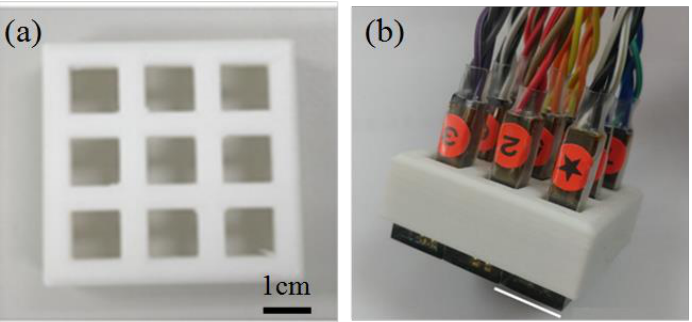
Figure 11. Photographs of: ( a ) 3D-printed Hall sensor frame, and ( b ) 3 × 3 Hall sensor array consisting of 9 sensing modules.